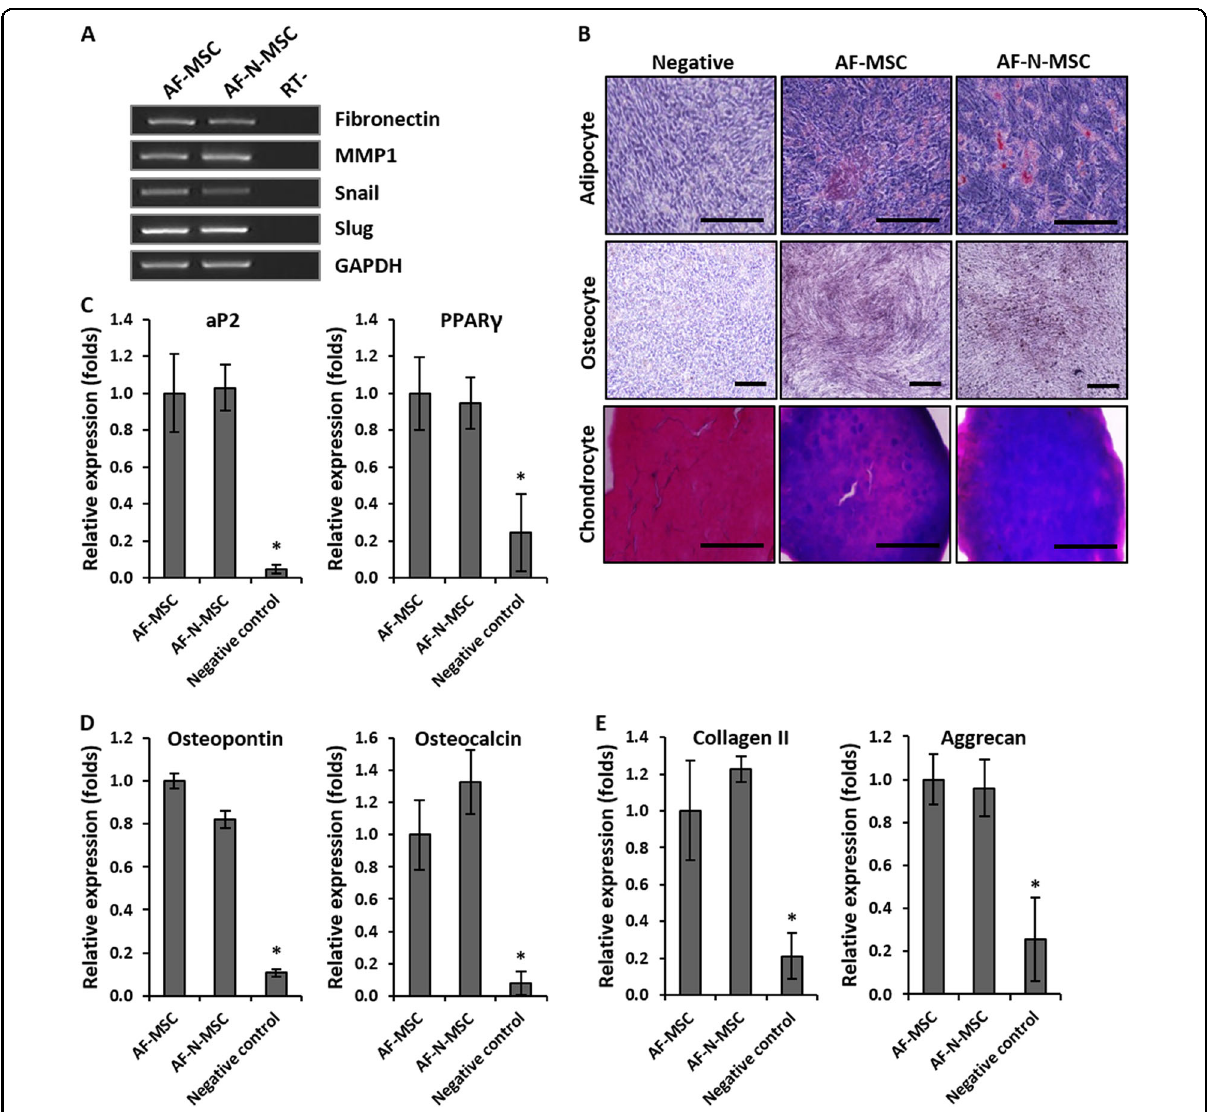
Fig. 3 Retention of the mesenchymal stem cell (MSC) phenotype of amniotic fl uid – derived MSCs (AF-MSCs). a Expression of mesenchymal lineage markers ( fi bronectin, MMP1, Snail, Slug) in AF- and AF-MSCs overexpressing Nanog (AF-N-MSCs). b Adipogenic, osteogenic, and chondrogenic differentiation of AF-N-MSCs at passage 20, evaluated by Oil Red O, von Kossa staining, and Alcian Blue staining, respectively. Scale bar, 200 µm. c mRNA expression analysis of adipogenic differentiation (aP2, PPAR γ ). d mRNA expression analysis of osteogenic differentiation (Osteopontin, Osteocalcin). e mRNA expression analysis of chondrogenic differentiation (Collagen II, Aggrecan). Data are represented as the mean ± SD ( n = 3). * p <